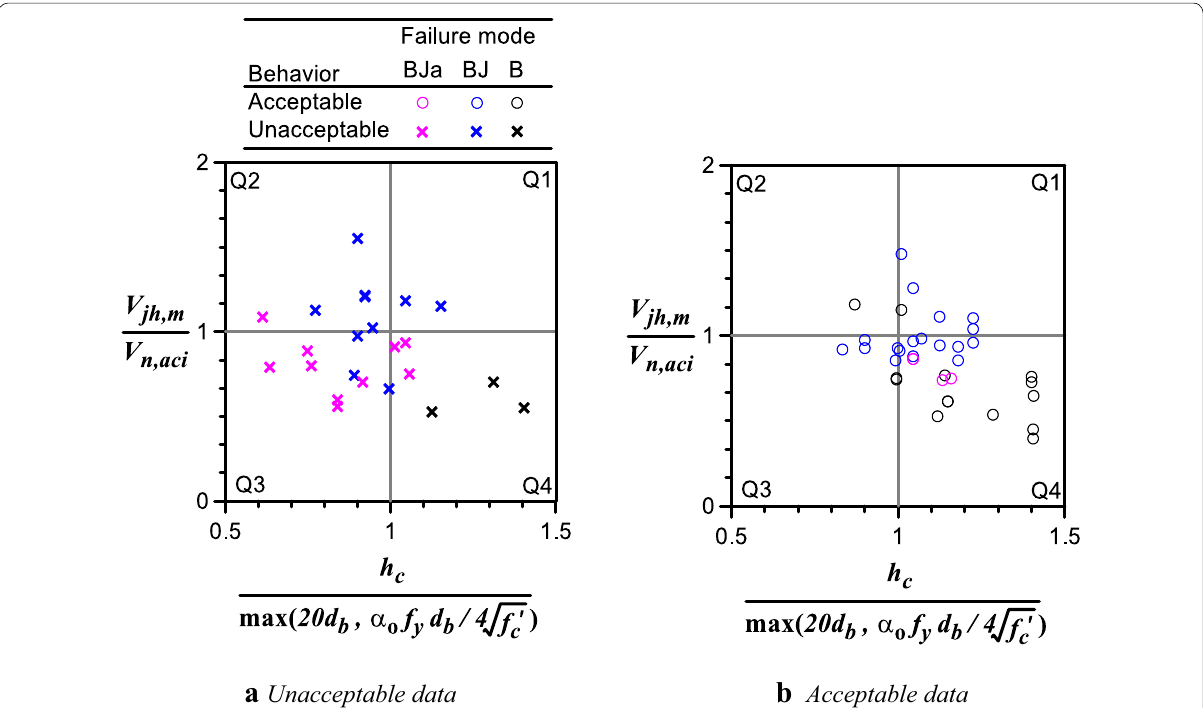
Fig. 11 Relations of performance evaluation to the shear strength ratio and provided‑to‑required joint depth